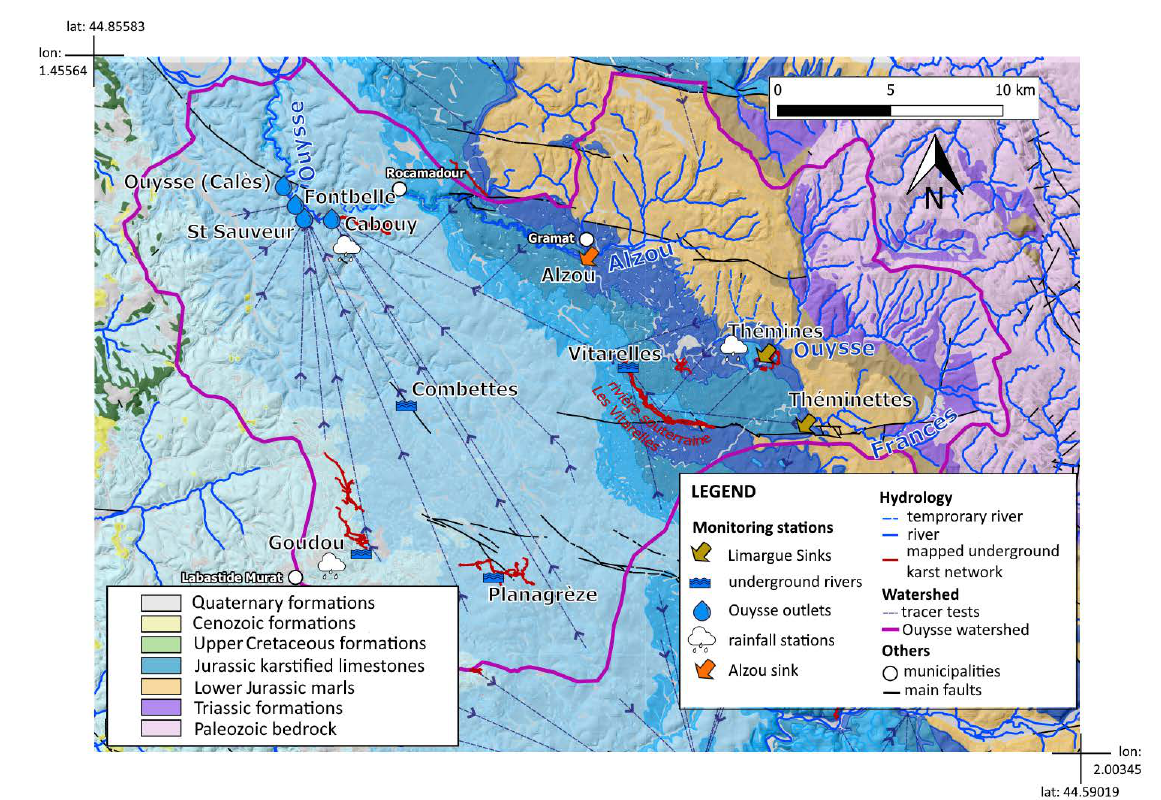
Figure 1. Geological map of the study area and location of the monitoring